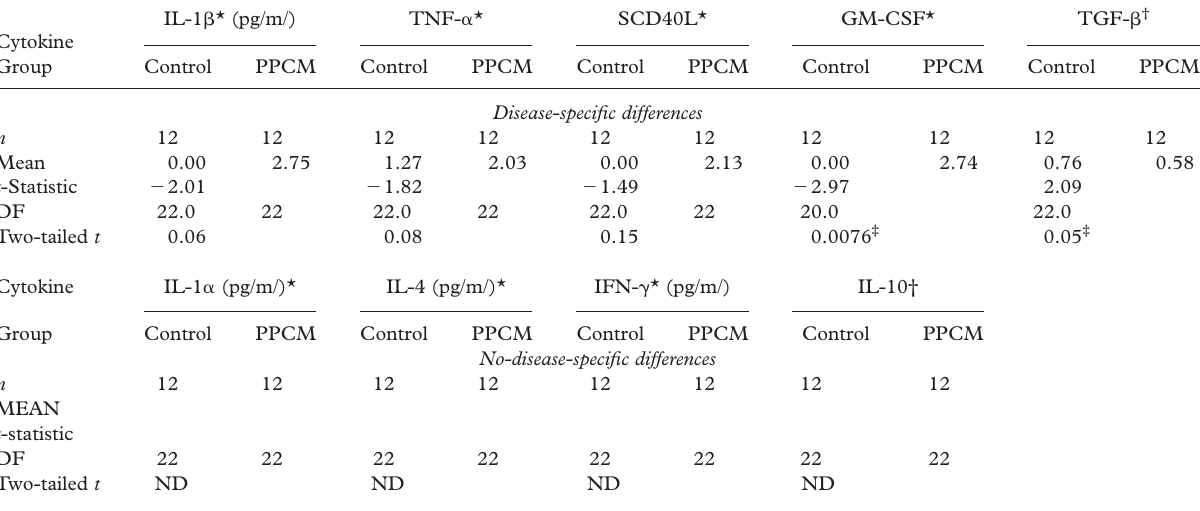
Table III. Plasma levels of cytokines and growth factors involved in DC maturation.